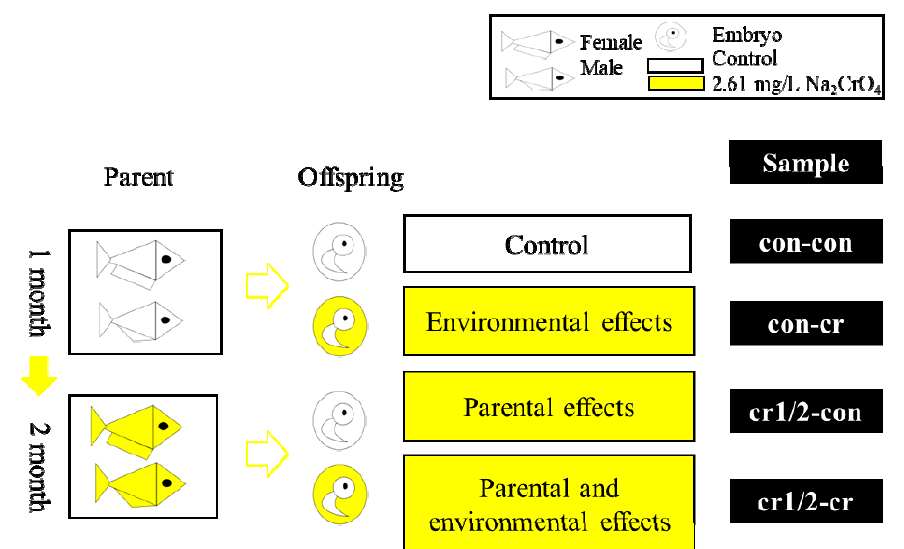
Figure 1. Diagram of experimental design for studying transgenerational effects of Cr(VI) of marine medaka. White represent control environment, yellow represents Cr(VI) treatment; there were four kinds of treatment, represented by “parental treatment-offspring treatment”, i.e., con-con, con-cr, cr1/2-con and cr1/2-cr; cr1 -con and cr1-cr represent treatments of the first month of parental treatment, cr2-con and cr2-cr represent treatments of the second month of parental treatment; con-cr was used to study developmental exposures, cr1/2-con was used to study parental effects, and cr1/2-cr was used to study combined effects of developmental exposures and parental effects.